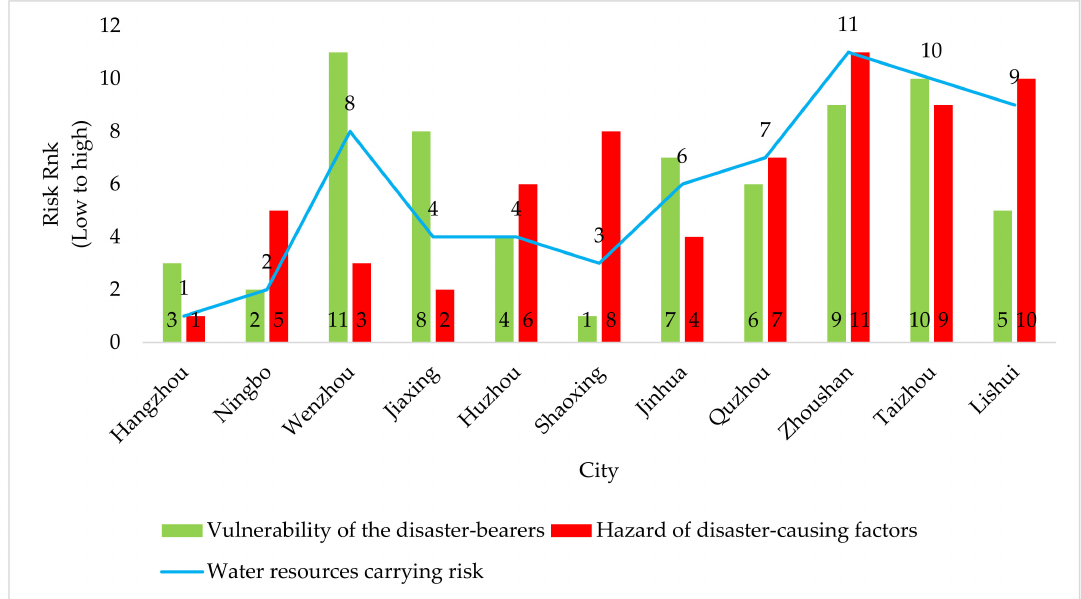
Figure 3. Each city’s ranking of vulnerability, hazards, and carrying risks of water resources in Zhejiang